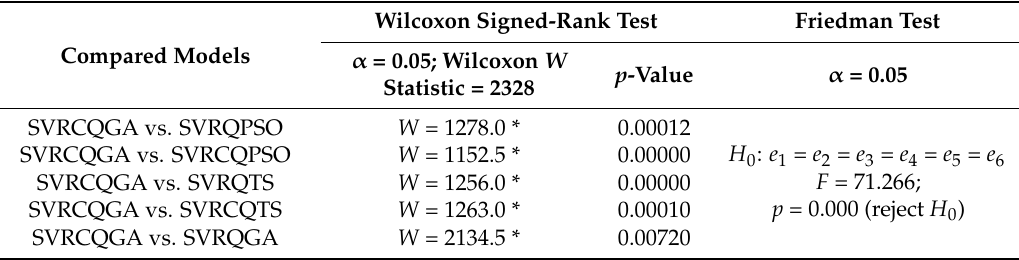
Figure 7. The cumulative differences of MAE for each competitive model (Example 3). Table 10. Wilcoxon signed-rank test and Friedman test (Example 3).